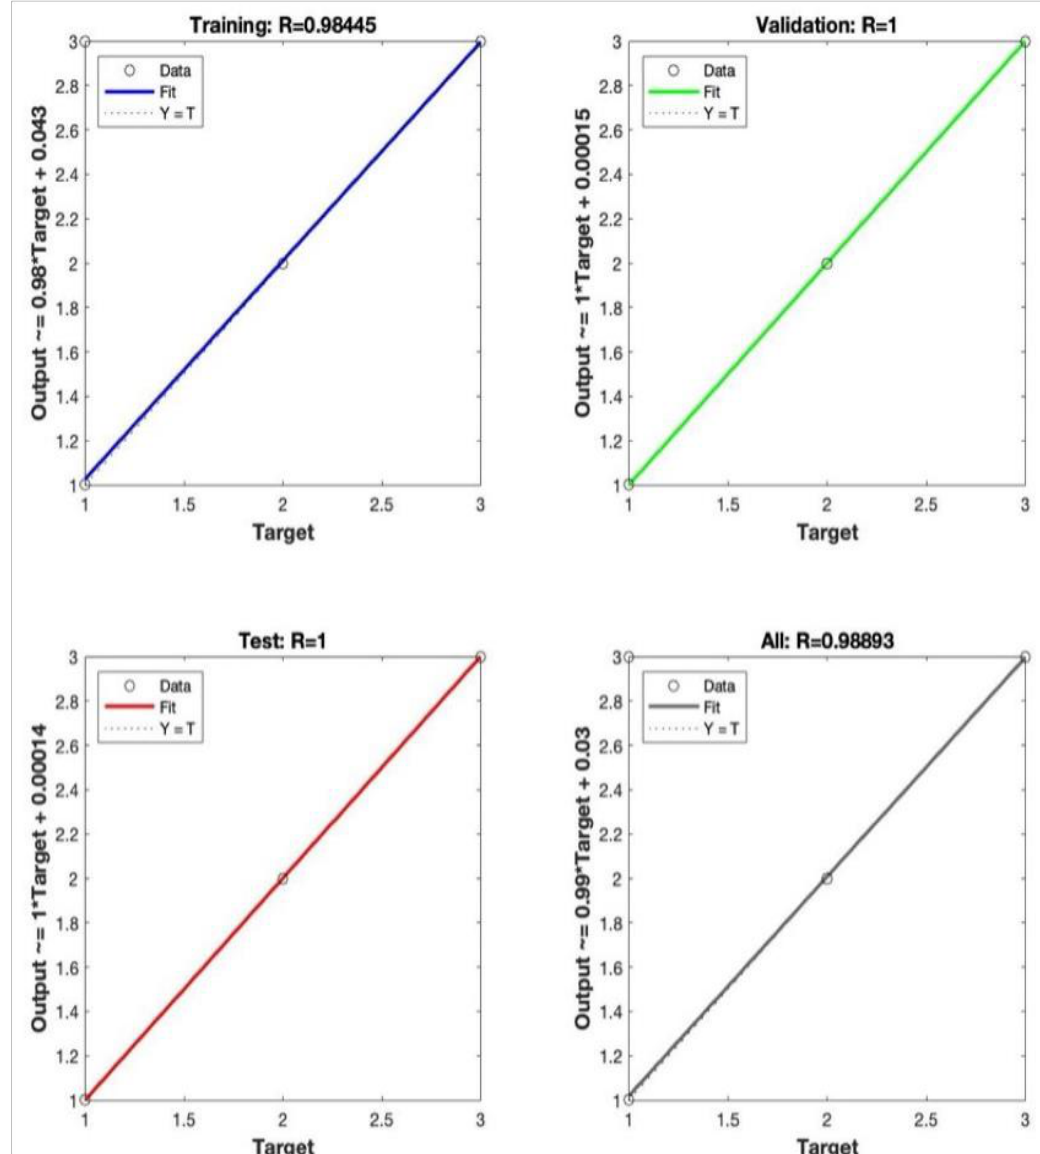
Figure 6: Regression plot of SubA_5chan_3LRF by BPN Classifier